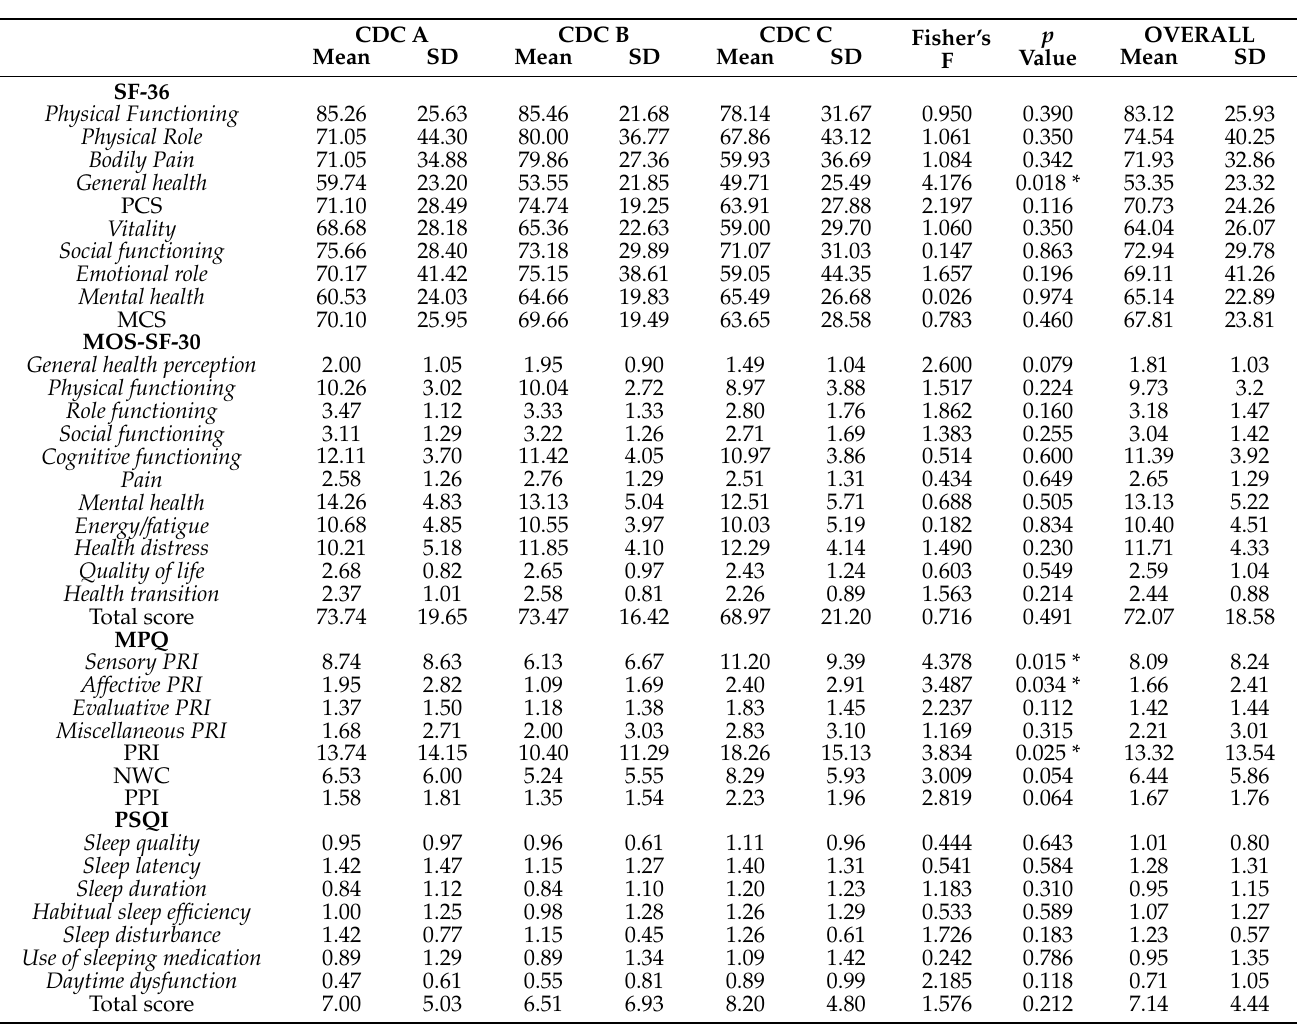
Table 2. Mean scores and percentiles for the various SF-36, MOS-SF-30, MPQ and PSQI questionnaire